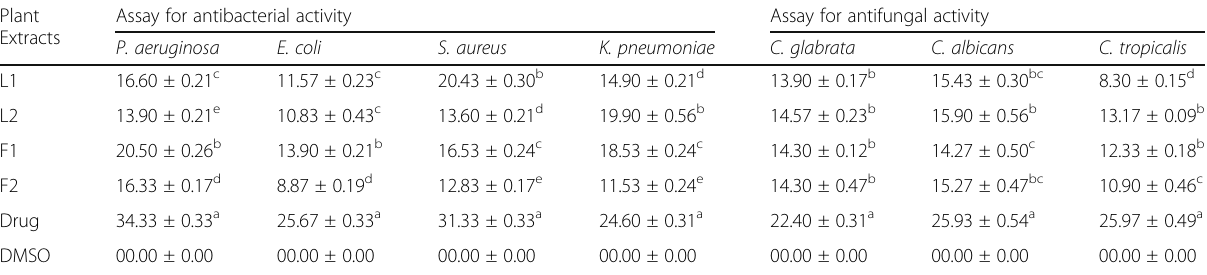
Table 2 The antibacterial and antifungal activity of the extracts of leaves and flowers of Saussurea obvallata determined using the well diffusion